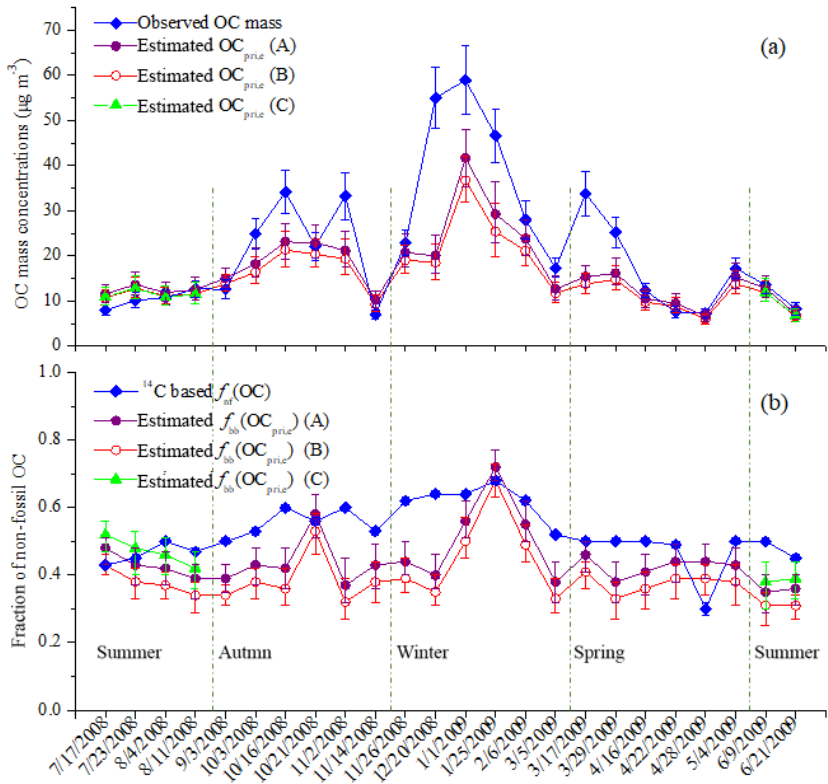
Figure 6. Estimated primary OC based on MCMC4 results. (a) Measured OC concentrations (blue line and diamond symbols) with obser- vational uncertainties (vertical bar) and estimated OC mass (OC pri , e , circle and triangular symbols) from apportioned EC and OC / EC ratios for different sources (Eq. 10). (b) 14 C-based fraction of non-fossil OC ( f nf (OC)) and modeled non-fossil fraction in OC pri , e (f bb (OC pri , e )) derived from Eq. (11). The interquartile range (25th–75th percentile) of the median OC pri , e and f bb (OC pri , e ) is shown by purple (A), red (B), and green (C) vertical bars. “A” and “B” denote different OC / EC ratios applied to primary biomass burning emissions ( r bb ): A: r bb = 5 (3–7, minimum–maximum); B: r bb = 4 (3–5); “C” denotes 80% r liq . fossil applied in summer with r bb = 5 (3–7). f nf (OC) uncertainties are indicated but are too small to be